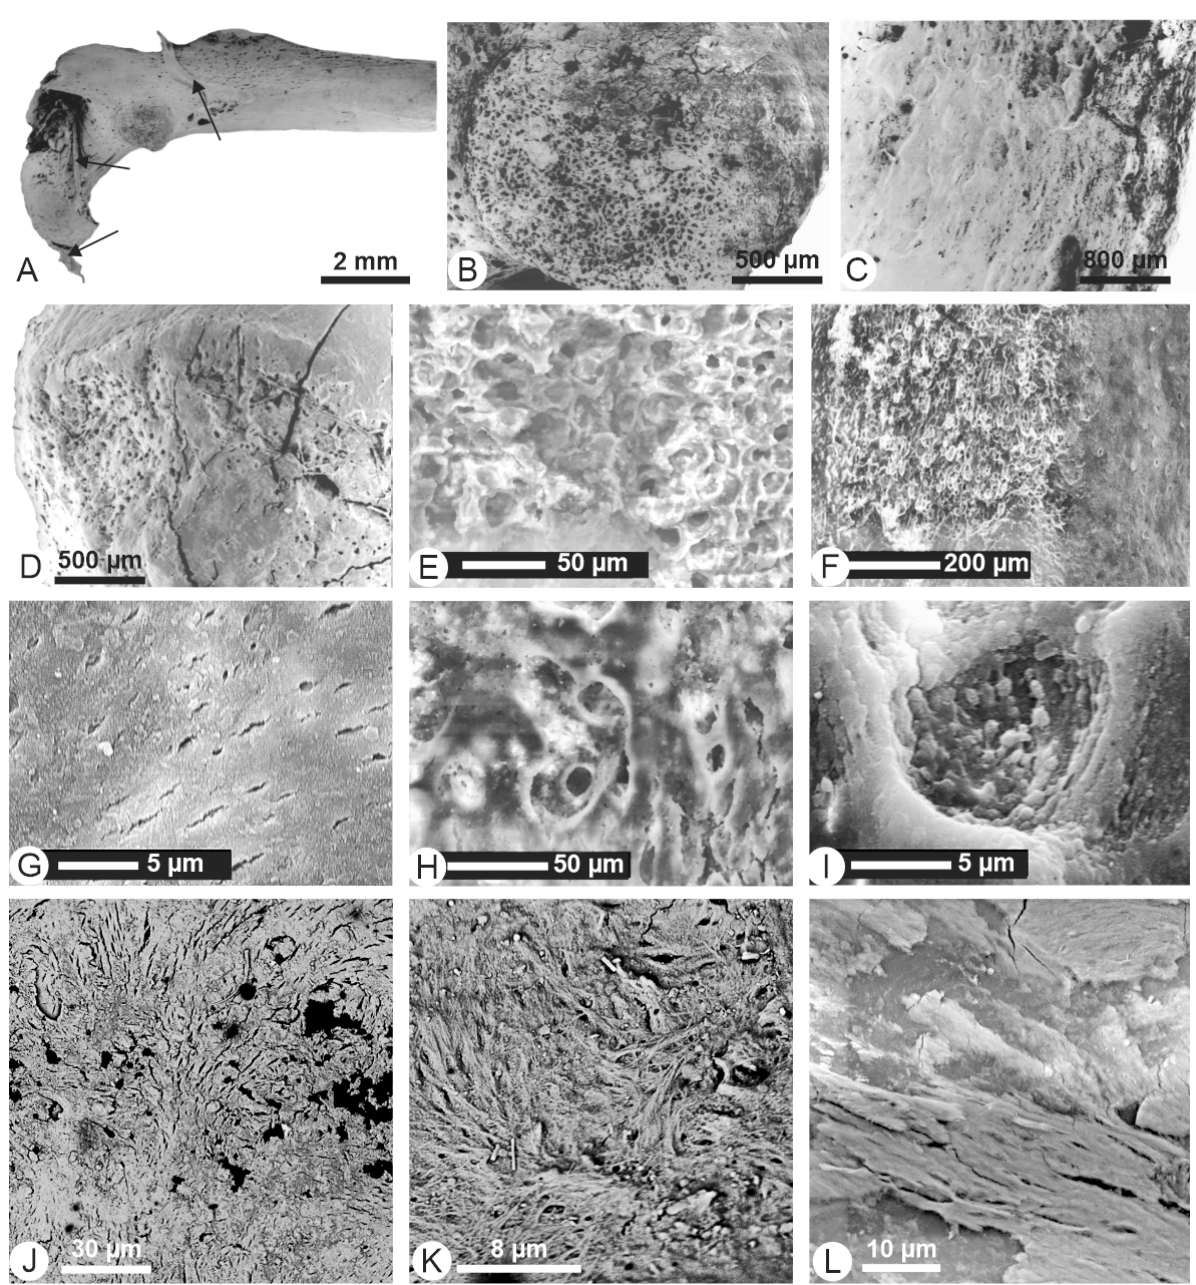
epiphysis (Figure 8G) and diaphysis surfaces (Figure 8H). The surface of the diaphysis is visible, and the haversian structure is displayed (Figure 8I).